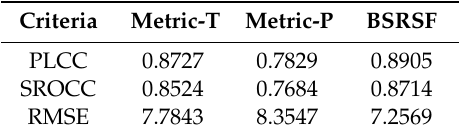
Table 6. E ff ects of features from textual and pictorial regions on